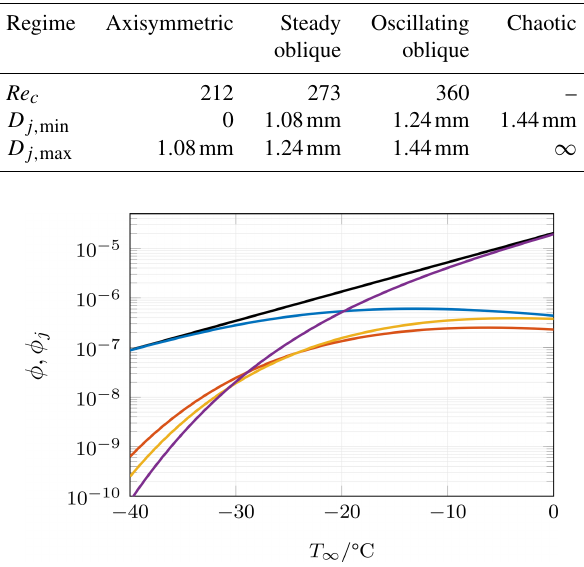
Table 1. Summary of the critical Reynolds numbers for regime tran- sition and the threshold diameters used to determine the partial vol- ume fractions.